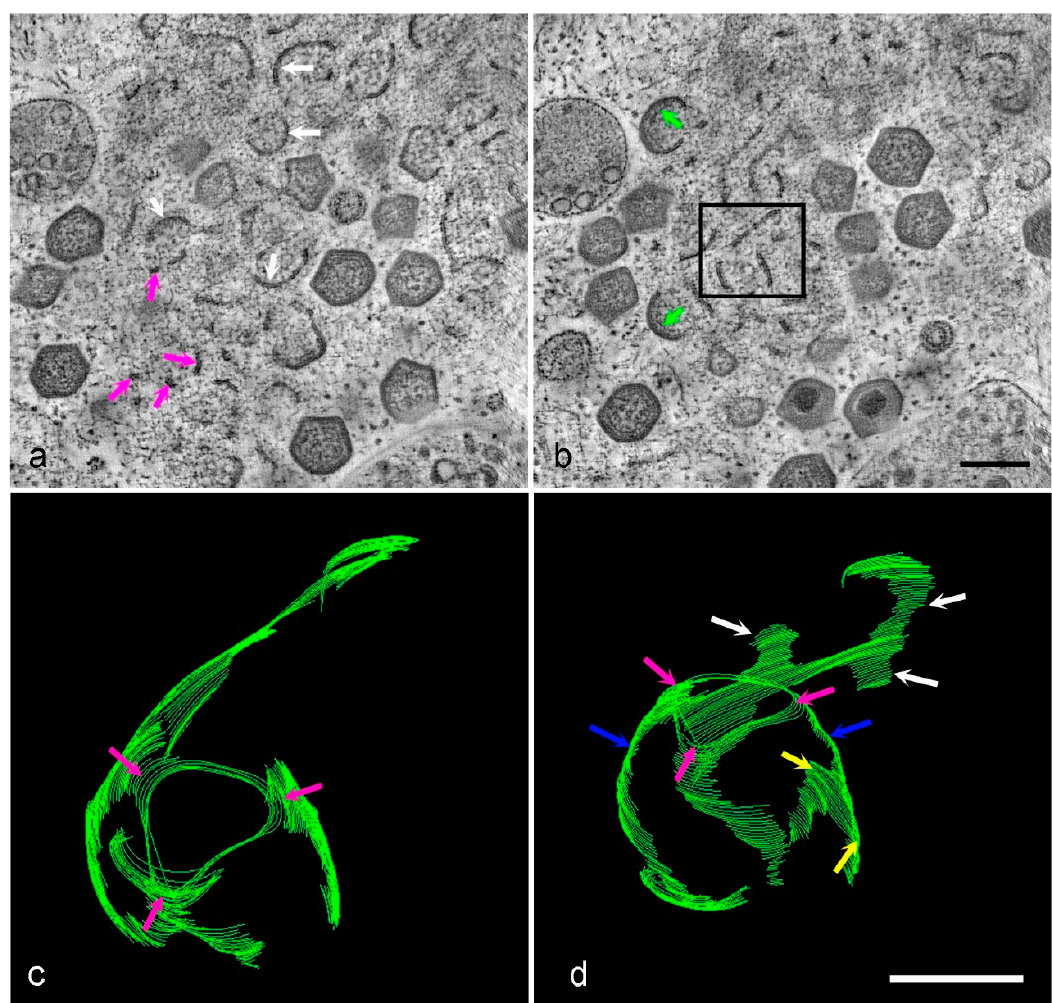
Figure 6. II. Tomographic reconstruction of HPF Vero cells at 18 hpi. ( a , b ) Two slices from the tomogram in supplemental data (Video S2). All forms of membrane assembly intermediates are visible, membrane fragments (pink arrows), larger curved (uncoated) membranes (white arrows) and membranes coated in capsid and core proteins (green arrows). The area in the black box in ( b ) was modeled and viewed from two different angles ( c , d ). Intriguingly, this area appeared to contain a ‘skeleton’ virus with a triangular pole ( c , d , pink arrows), vertical links down the body of the template ( d , blue arrows) and horizontal spread of membrane at the center ( d , yellow arrows). There appears to be a branched connection to one side ( d , white arrows) which may link to other forming virions. Scale bars: b = 200 nm, d = 100 nm.